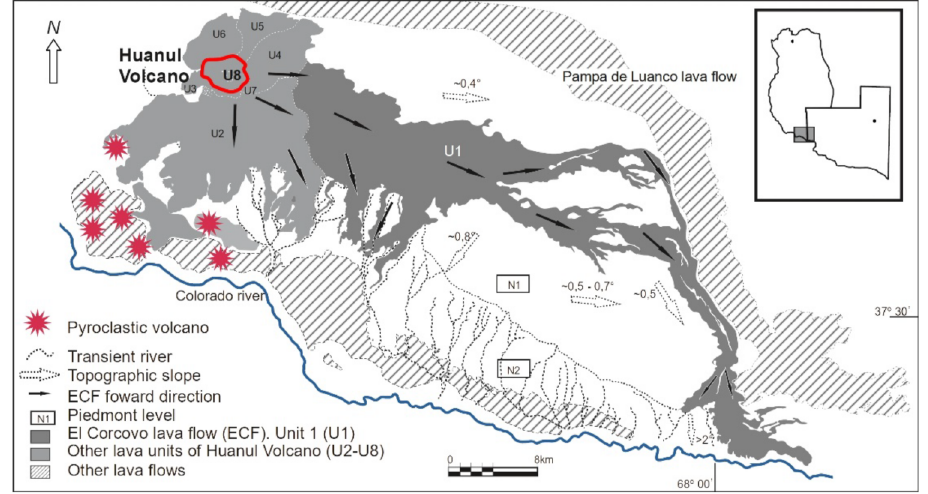
Figure 2. Local geological setting and topographic features of the lava flows of Huanul volcano and surrounding area of the Rio Colorado Volcanic Field modified after Bernardi et al. [21]. The xenoliths were collected from Unit 8 in the red-circled area. ECF: El Corcovo Lava